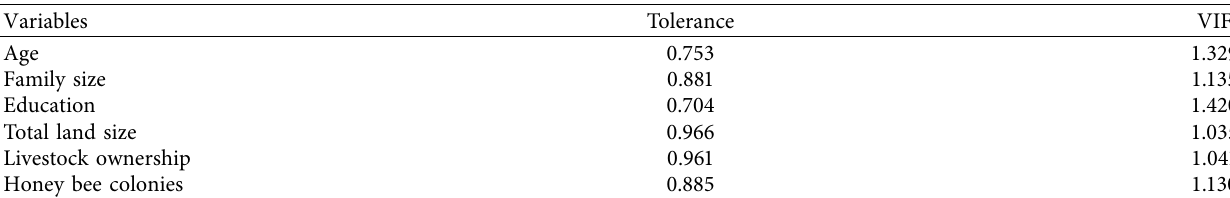
Table 21: Variance inflation factor (VIF) and tolerance of continuous explanatory